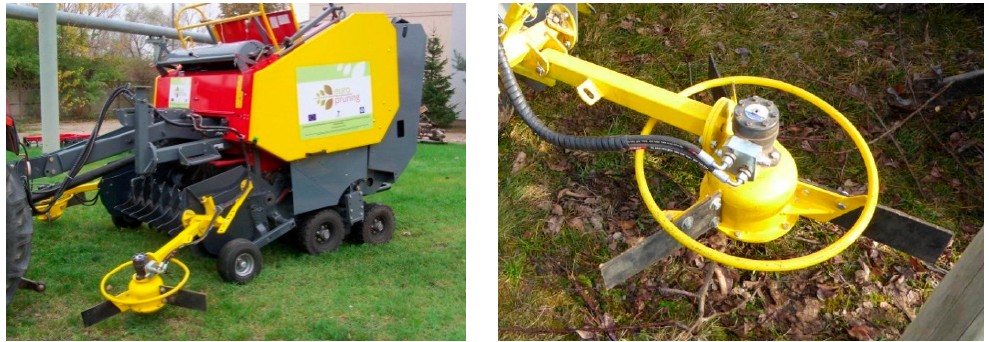
Figure 1. Pruning round baler PRB 1.75 with windrowers.